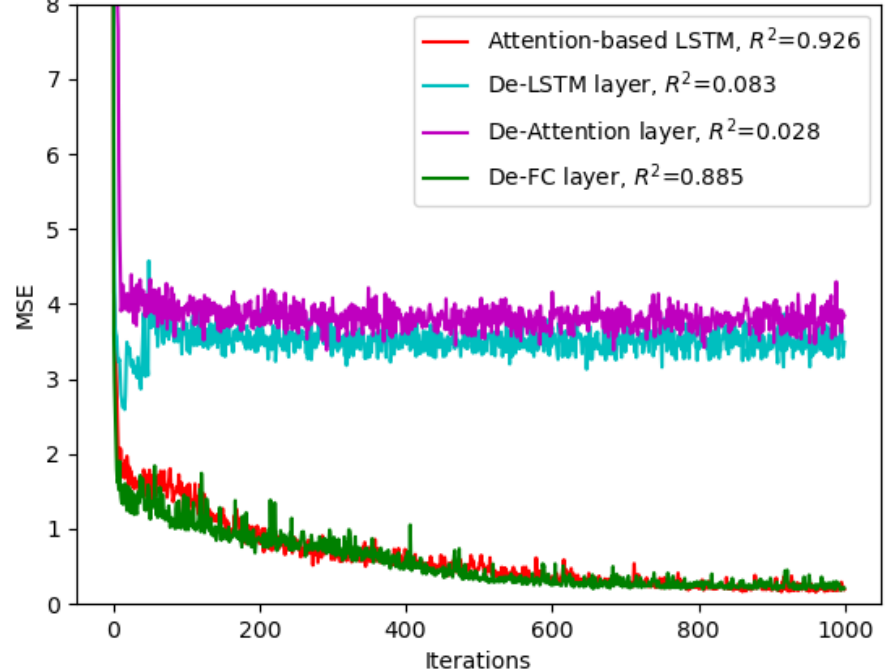
Figure 6. Influence of attention-based LSTM layer structure on loss convergence of training iterative process.